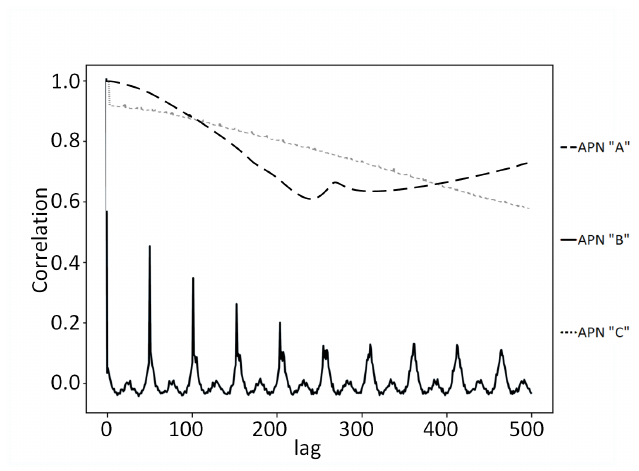
Figure 17. Packet count correlation: APN A (dash), APN B (line), APN C (dotted)